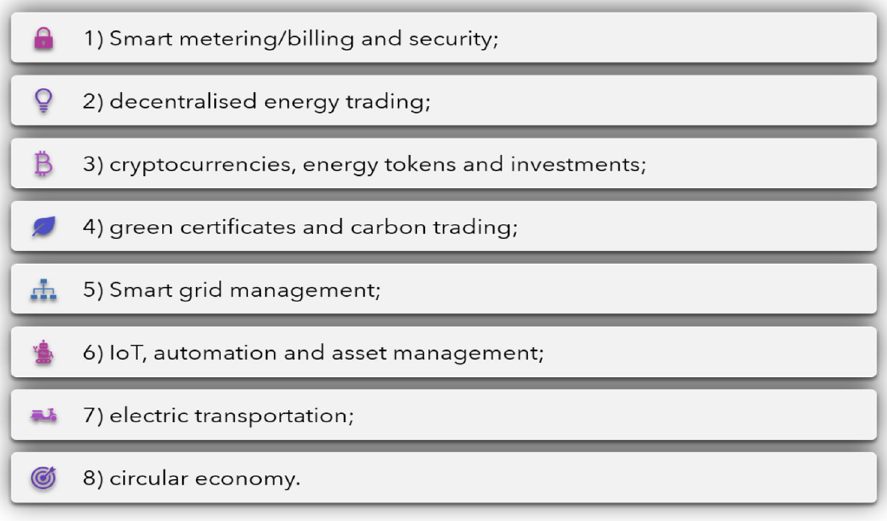
Figure 2. Applications of blockchain technology in the renewable energy industry.